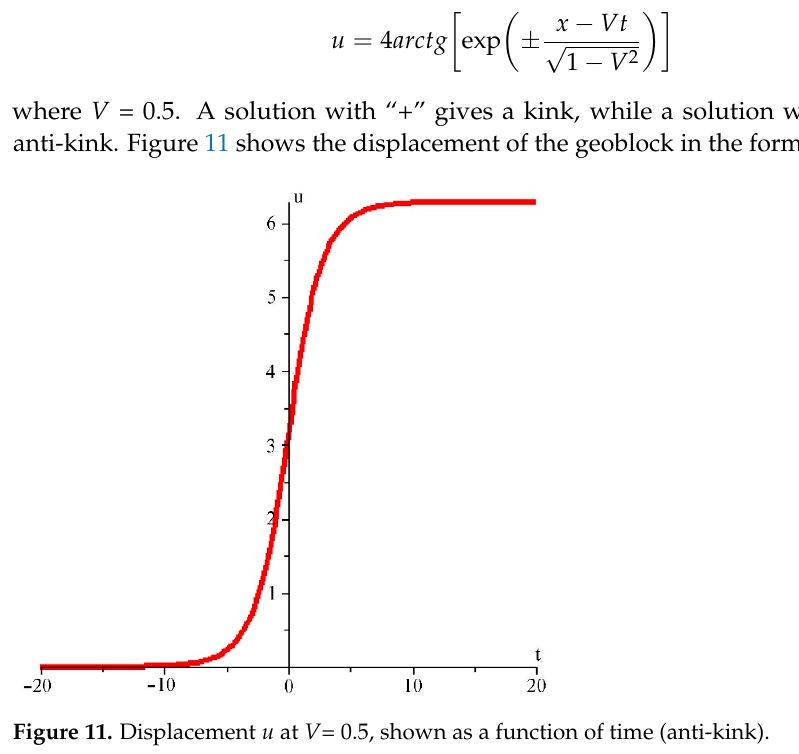
V = 0.5, demonstrating